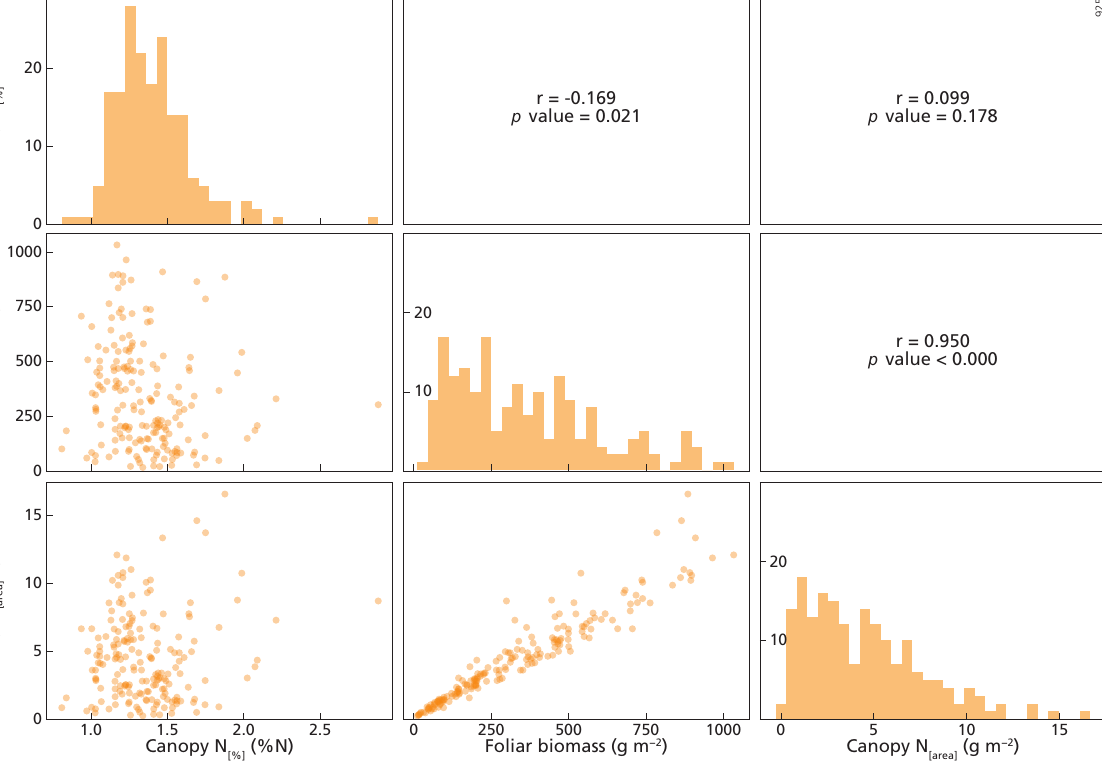
Figure A3. The upper right part of this figure shows the Pearson correlation matrix between canopy N [ % ] (%N), canopy N [ area ] (gm − 2 ) and foliar biomass (gm − 2 ) variables for evergreen broadleaf forest (EBF) plots, n = 186. The diagonal presents the histogram of the variable on the x axis, while the y axis represents the number of counts. The lower left part of this figure represents the scatterplots between the variables.